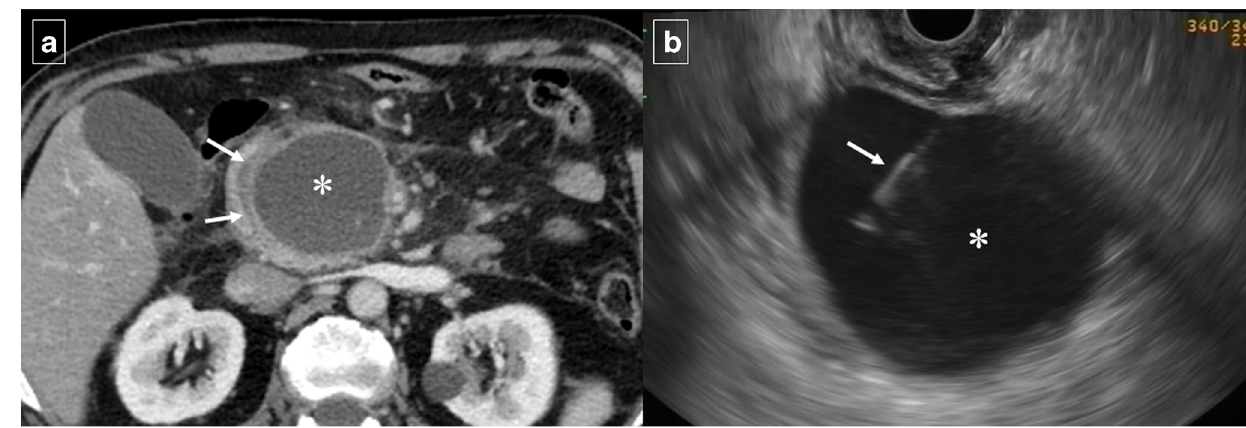
Fig.14 Duodenal compression bypancreatic pseudocyst in a 69-year-old man. a Axial contrast-enhanced CT reveals lateral displacement of the descending duodenum (arrows) by a pancreatic fluid collection (*). b